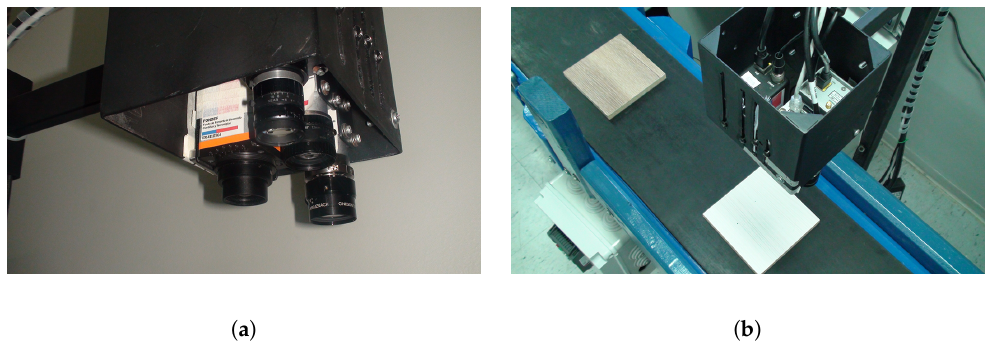
Figure 2. Experimental setup (( a ) Multispectral camera rig, ( b ) Conveyor prototype).